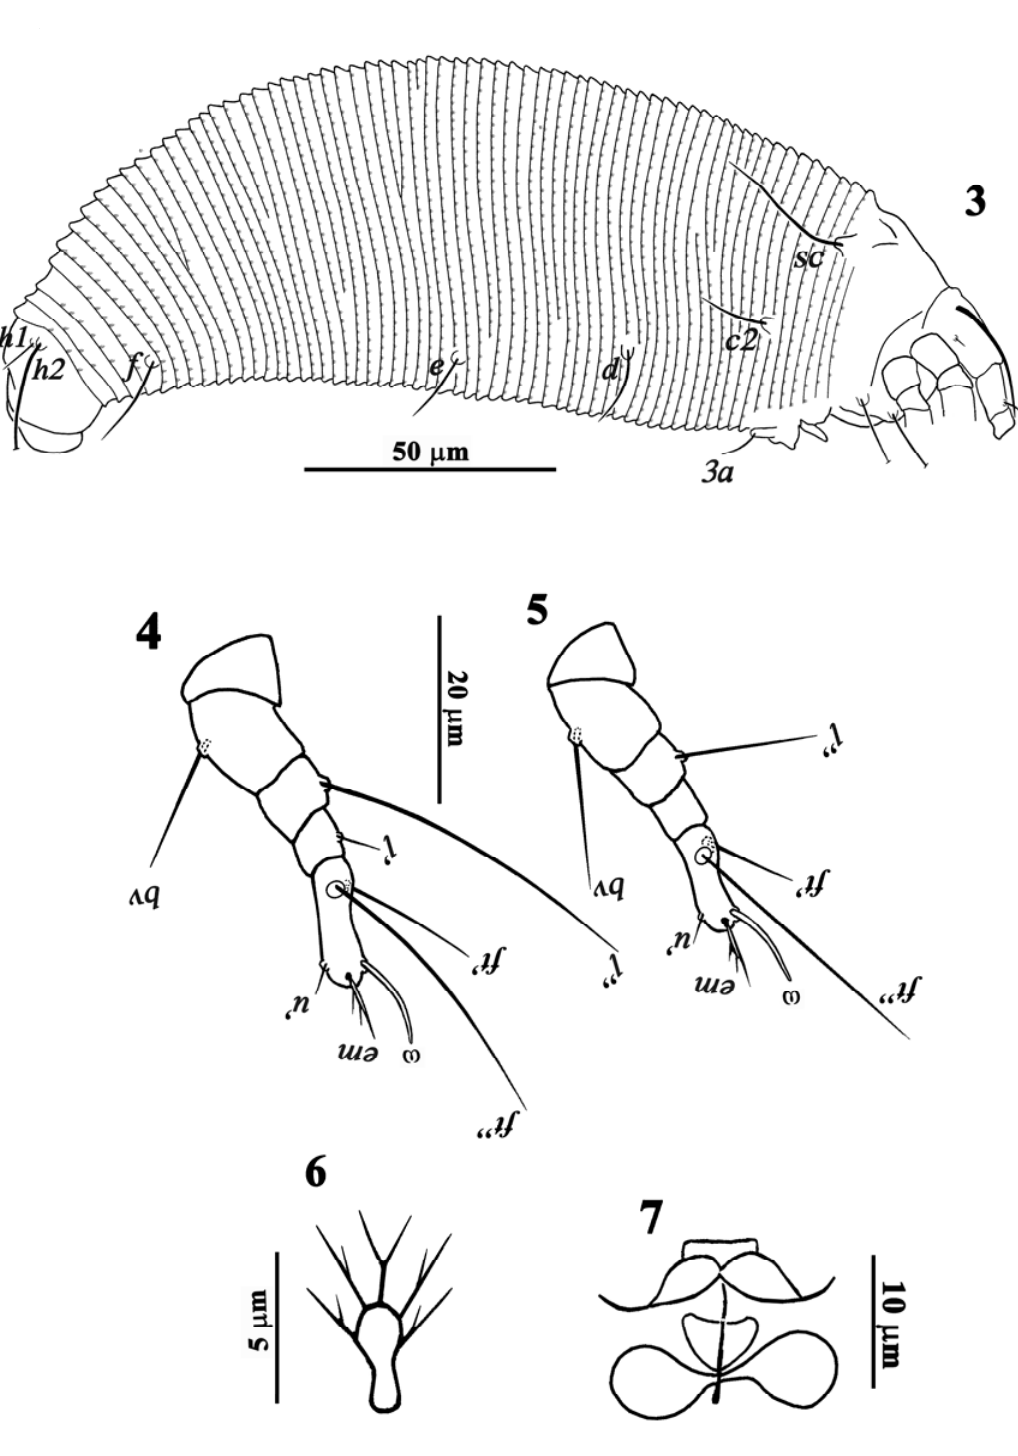
Leg I; 5. Leg II; 6. Empodium; 7. Internal